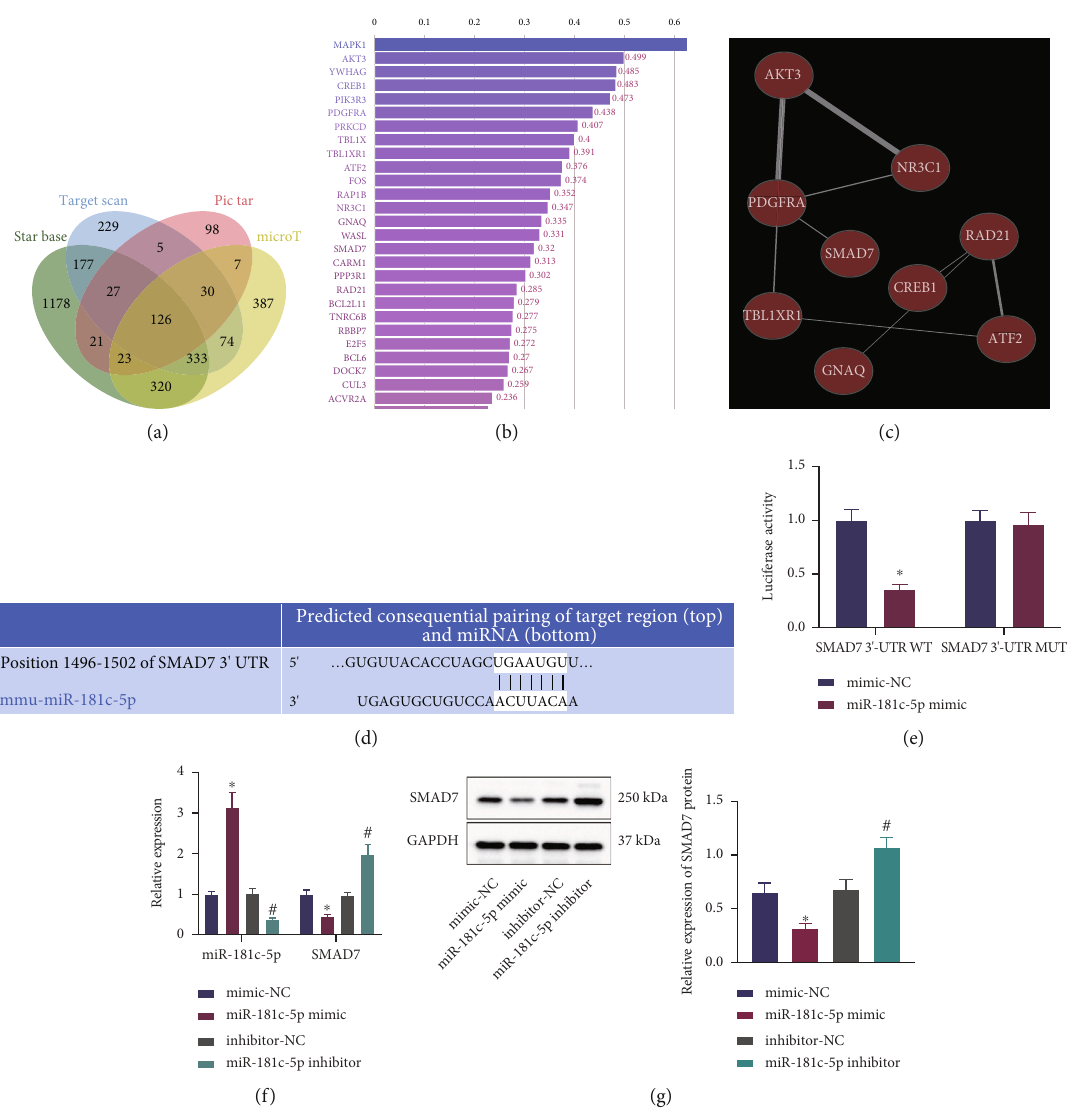
Figure 4: Regulation of SMAD7 expression by miR-181c-5p in BMSCs. (a) Venn diagram of the intersection of predictive results of the target genes of miR-181c-5p from StarBase, TargetScan, PicTar, and microT. (b) Correlation bar graph of candidate target genes and cartilage analyzed by using a PH&Enolyzer tool. (c) Network map of coexpression relationship of candidate genes analyzed by using a PH&Enolyzer tool. (d) The binding sites of miR-181c-5p and SMAD7 predicted by the TargetScan database. (e) The targeting relationship between miR-181c-5p and SMAD7 veri fi ed by the dual-luciferase reporter gene assay. (f) miR-181c-5p expression and SMAD7 mRNA level in BMSCs treated with the miR-181c-5p mimic or inhibitor determined by RT-qPCR. (g) SMAD7 protein level in BMSCs treated with the miR-181c-5p mimic or inhibitor measured by Western blot analysis. ∗ p < 0 : 05 , compared with BMSCs transduced with mimic-NC; # p < 0 : 05 , compared with BMSCs transduced with inhibitor-NC. All experiments were repeated for three